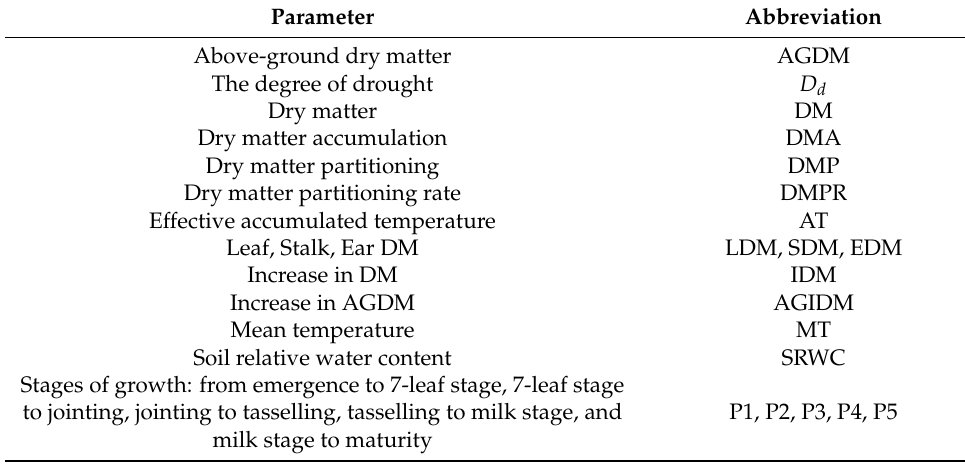
Table 1. Abbreviations used to denote each parameter.